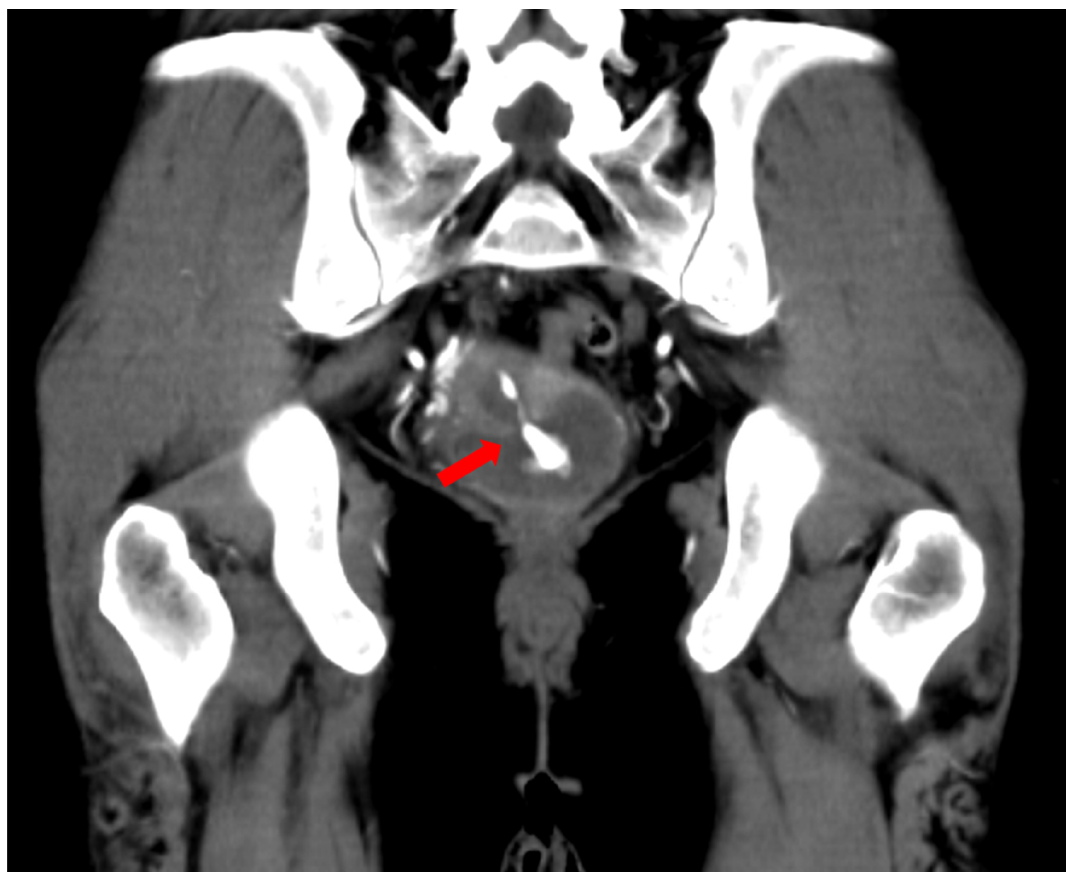
Figure 1. A case of a 40-year-old woman with massive vaginal bleeding. She underwent transvagi- nal US-directed follicle aspiration for oocyte retrieval 6 h earlier. Contrast-enhanced computed to- mography (CT) on admission reveals active bleeding from the uterine ostium (arrow).